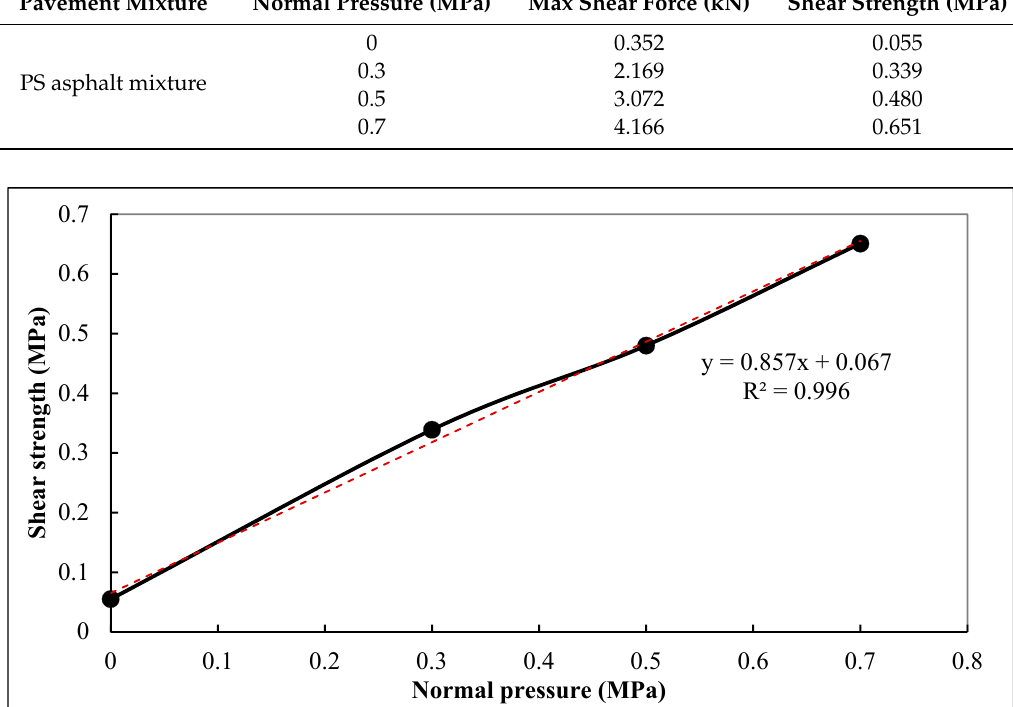
Table 6. Results of interlaminar shear tests at different temperatures. Mixture Type Temperature ( ℃ ) Maximum Shear (kN)